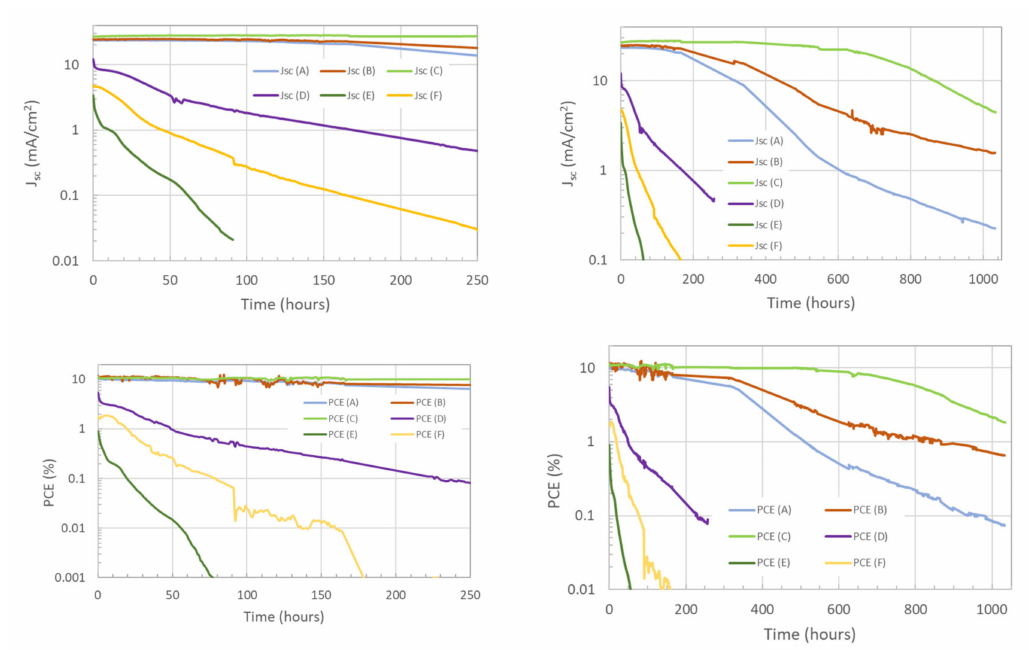
Figure 4. Short circuit current (J sc. , upper plots) and power conversion efficiency (PCE, lower plots) of the six samples. Logarithmic axis for short circuit current emphasizes the rapid drop for the set of D, E, F samples (up to 250 h) while the A, B, C had much longer lifetimes, extended more than 1000 h. For better visualization, left figures show the first 250 h of the experiments while right figures show the complete experiments.